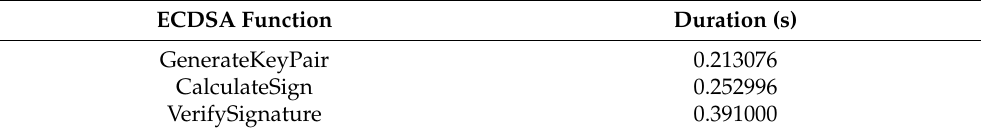
Table 4. Measurements of the executed ECDSA functions based on the RELIC library on the MDUINO device. ECDSA